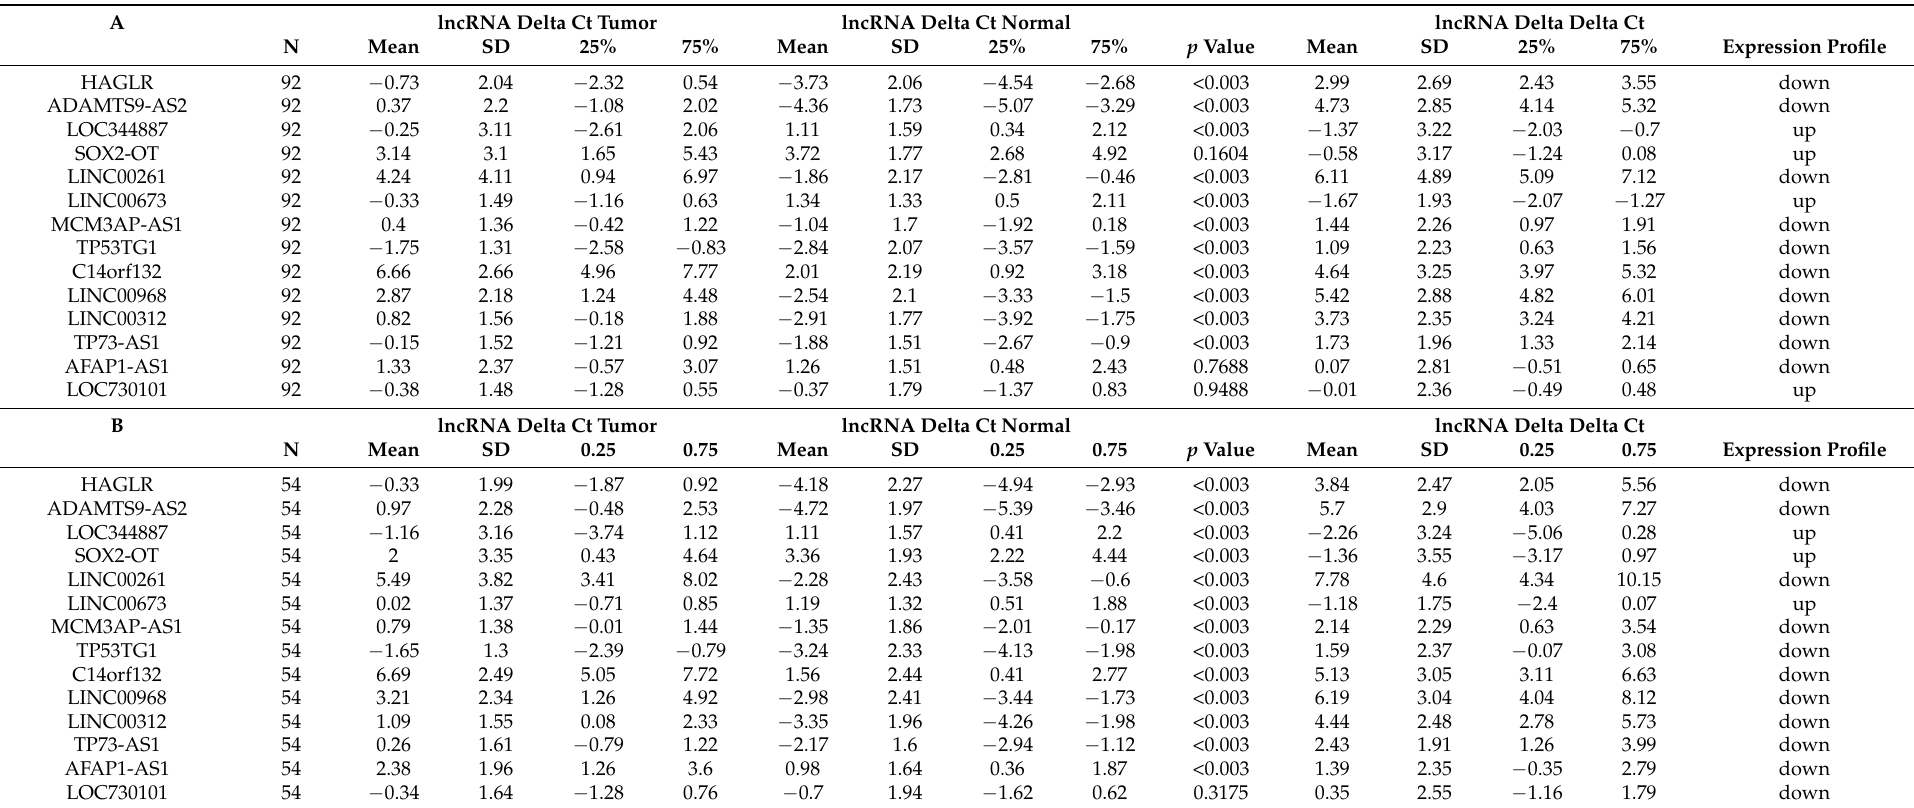
Table 3. Expression of 14 lncRNA in tumor tissue vs. normal tissue; ( A ) non-small cell lung cancer (NSCLC); ( B ) squamous cell lung carcinoma (LUSC); ( C ) lung adenocarcinoma